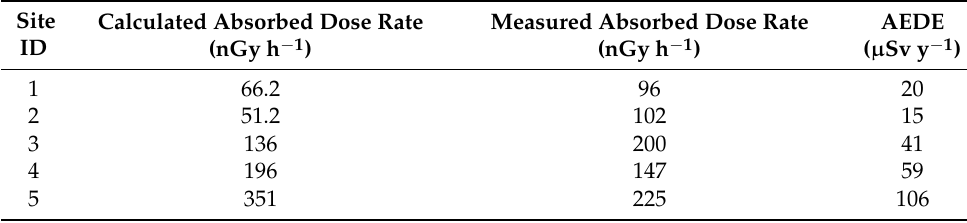
Table 3. Calculated and measured values of the absorbed dose rate, and AEDE, for the analysed